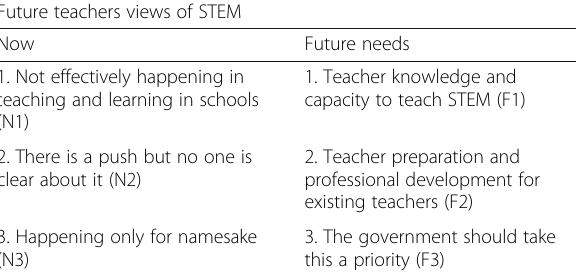
Table 2 The response generated from the qualitative data regarding what is happening now and future